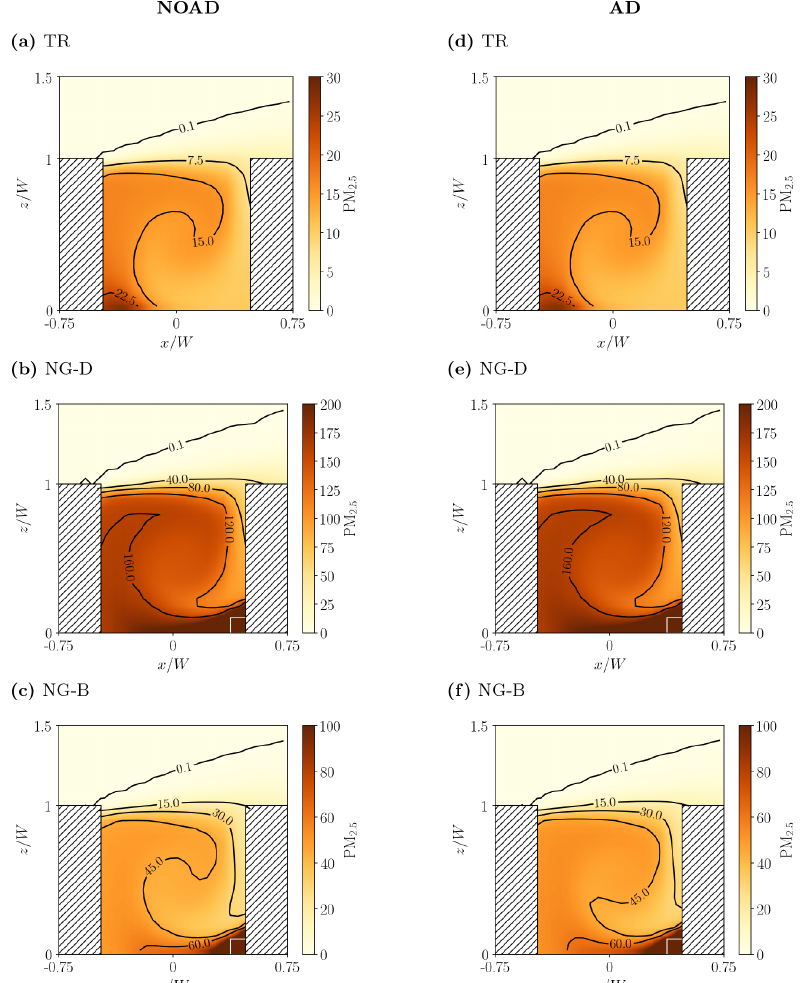
Figure D1. As in Fig. 6 but for PM 2 . 5 concentrations. The mass concentrations are largely insensitive to aerosol dynamic